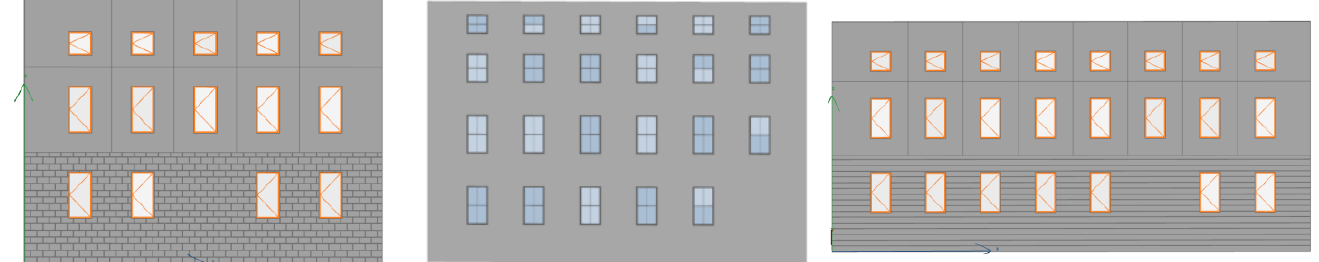
Figure 13. Various configurations of classical parametric façades automatically generated using shape